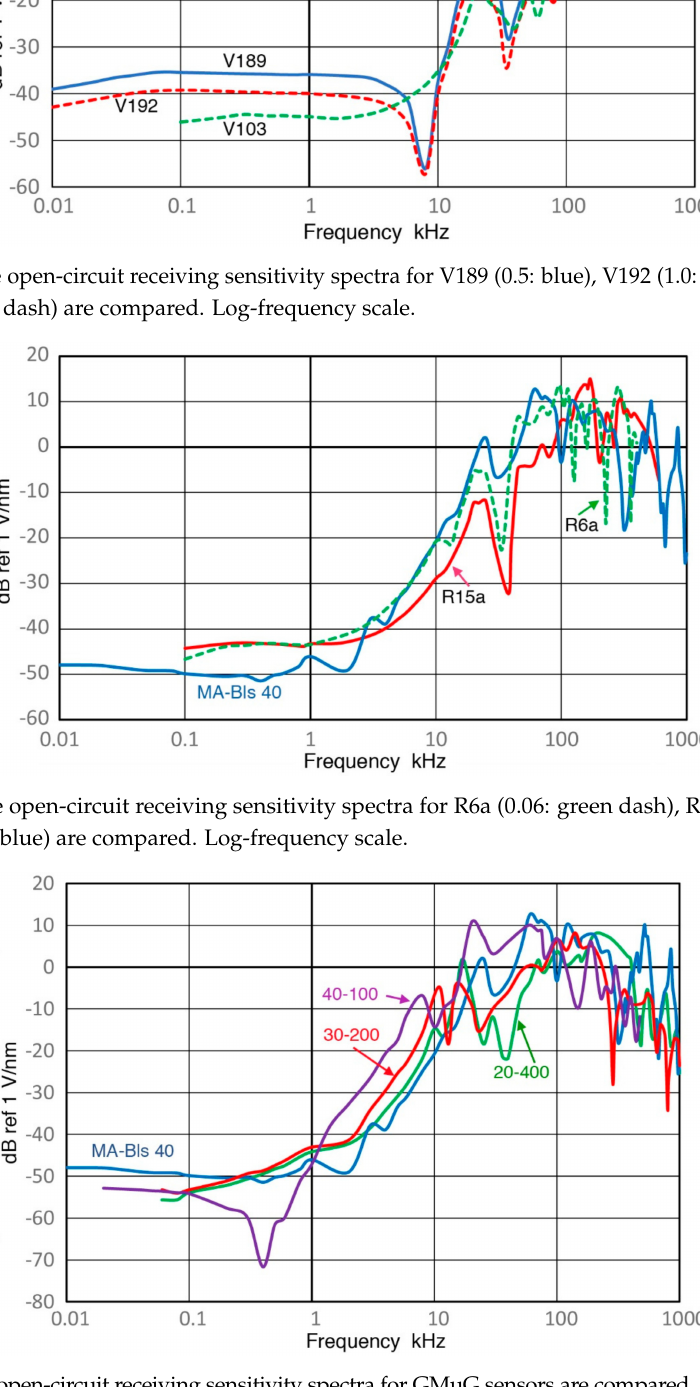
Figure 22. Four open-circuit receiving sensitivity spectra for GMuG sensors are compared. Log-frequency scale. MA-Bls 40 (blue); MA-Bls 40–100 (purple); MA-Bls 30–200 (red); MA-20–400